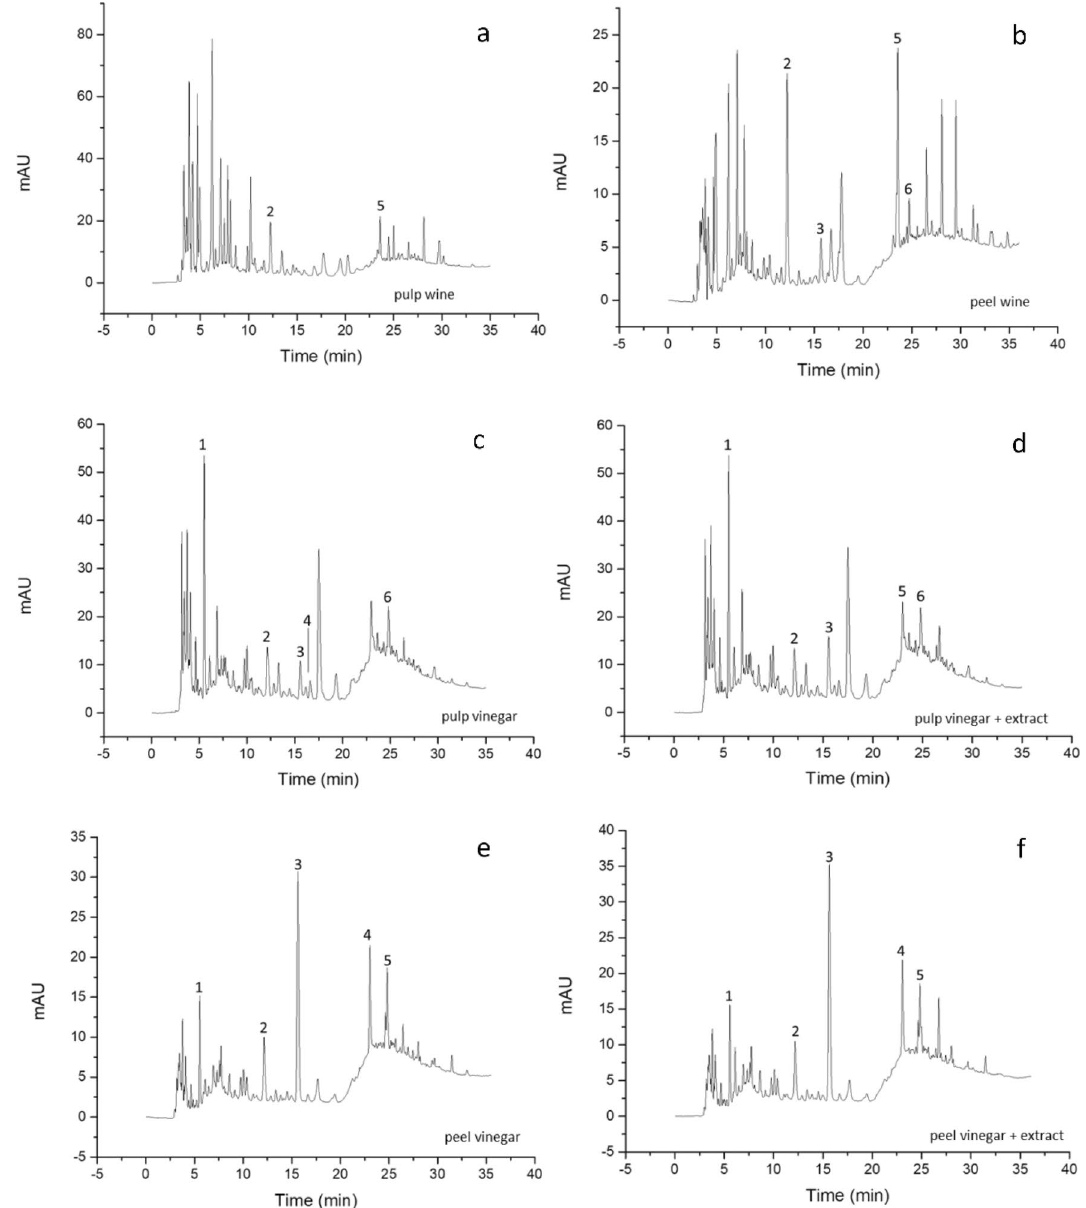
Figure 3. HPLC–DAD chromatograms for samples of ( a ) pulp wine, ( b ) peel wine, ( c ) pulp vinegar, ( d ) pulp vinegar + extract, ( e ) peel vinegar, ( f ) peel vinegar + extract. Gallic acid (1), catechin (2), caffeic acid (3), epicatechin (4), coumaric acid (5), ferulic acid